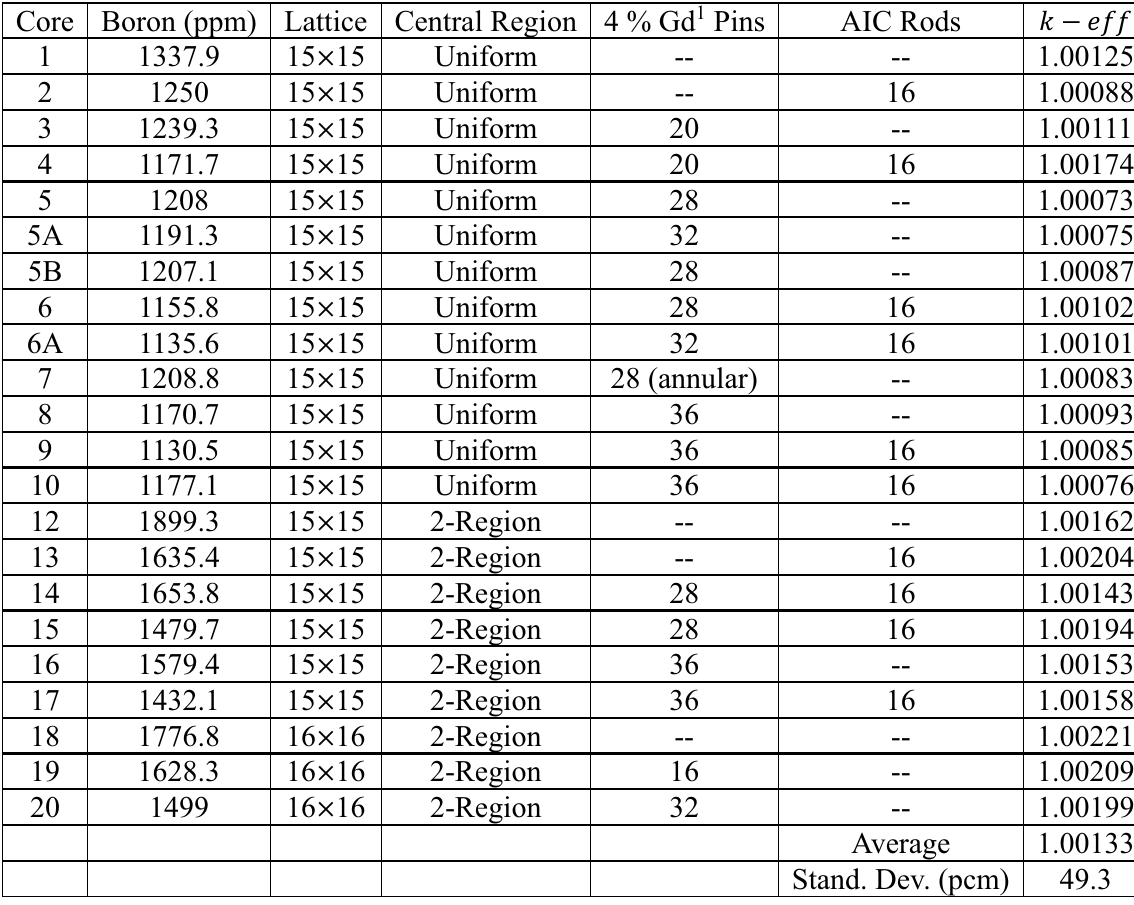
Figure 2. CASMO5 multi-assembly depiction of B&W 1810 Core 1 (left) and Core 18 (right). Core 1 is similar to cores 2-17 and Core 18 is similar to cores 19-20. Table I. CASMO5 B&W 1810 critical experiments : k–eff results